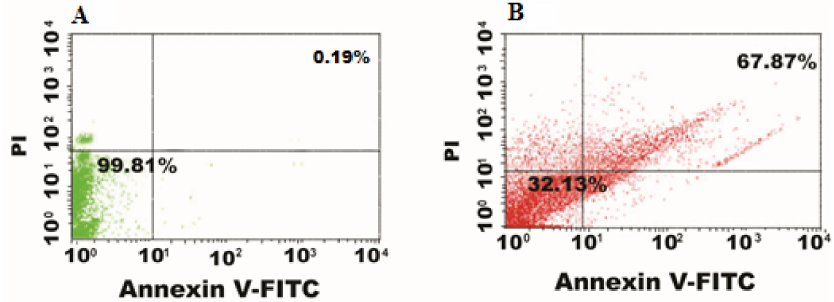
Figure 8. Flow cytometer data nanohybrid-induced cell death. ( A ) control (untreated), ( B ) CIP- TiO 2 /Ag/CS nanohybrid-treated E. coli